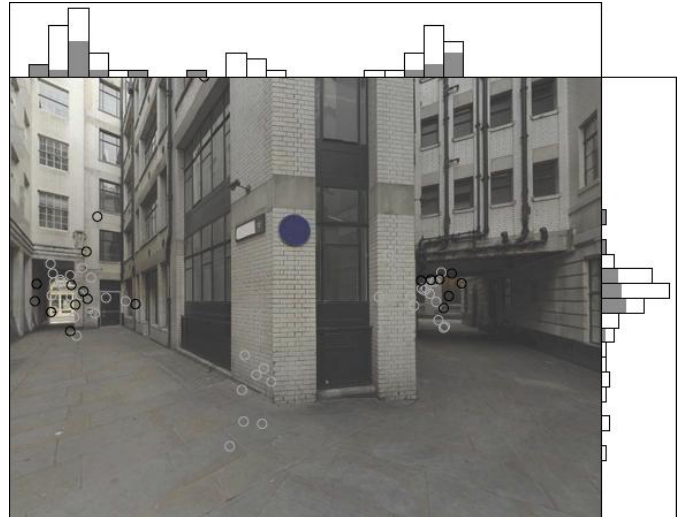
Figure 5. Comparison of the fixation data between the undirected (white) and directed spatial tasks (black fixation and bars), showing data from all participants for one